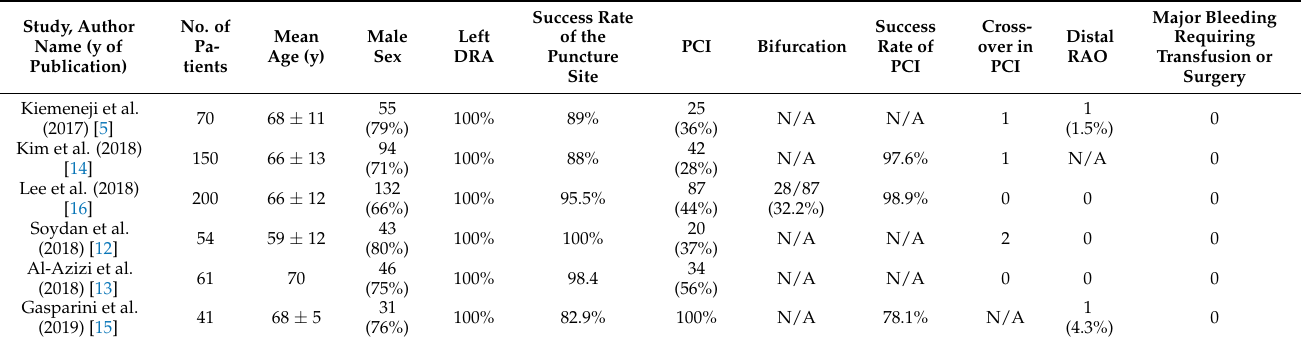
Table 4. Summary of previous articles regarding the left